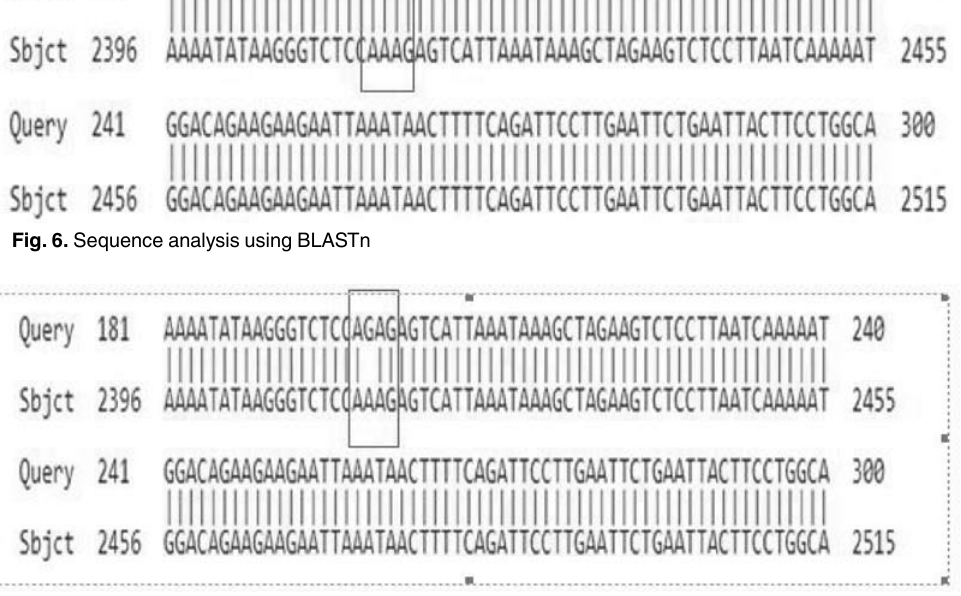
Fig. 7. Sequence analysis using BLASTn showing A to G variation